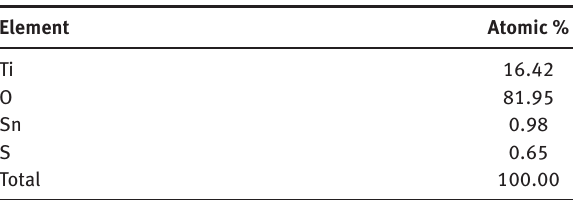
Table 1: Elemental composition of sample TiO EDX